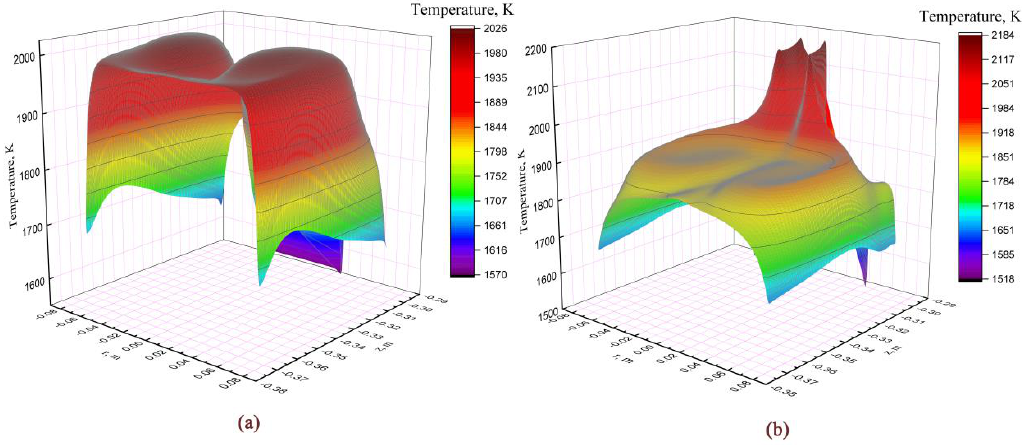
Figure 10. Surface map of temperature distribution in slag pool. ( a ) OE-ESR. ( b ) TSCE-ESR. Table 2. Average temperature in the slag pool area and the radial temperature gradient at the slag/electrode interface.